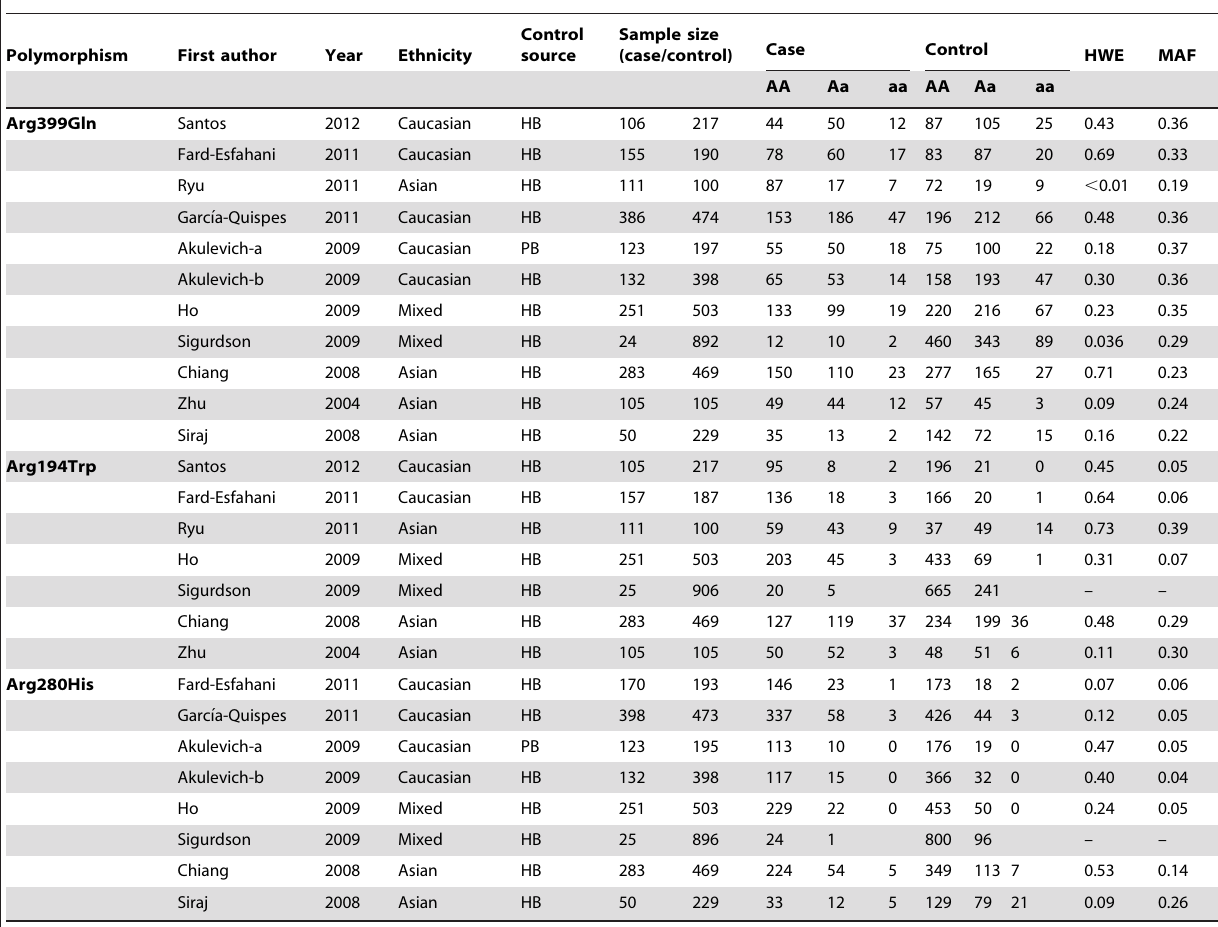
Table 2. Genotype distribution of XRCC1 polymorphisms used in the meta-analysis.